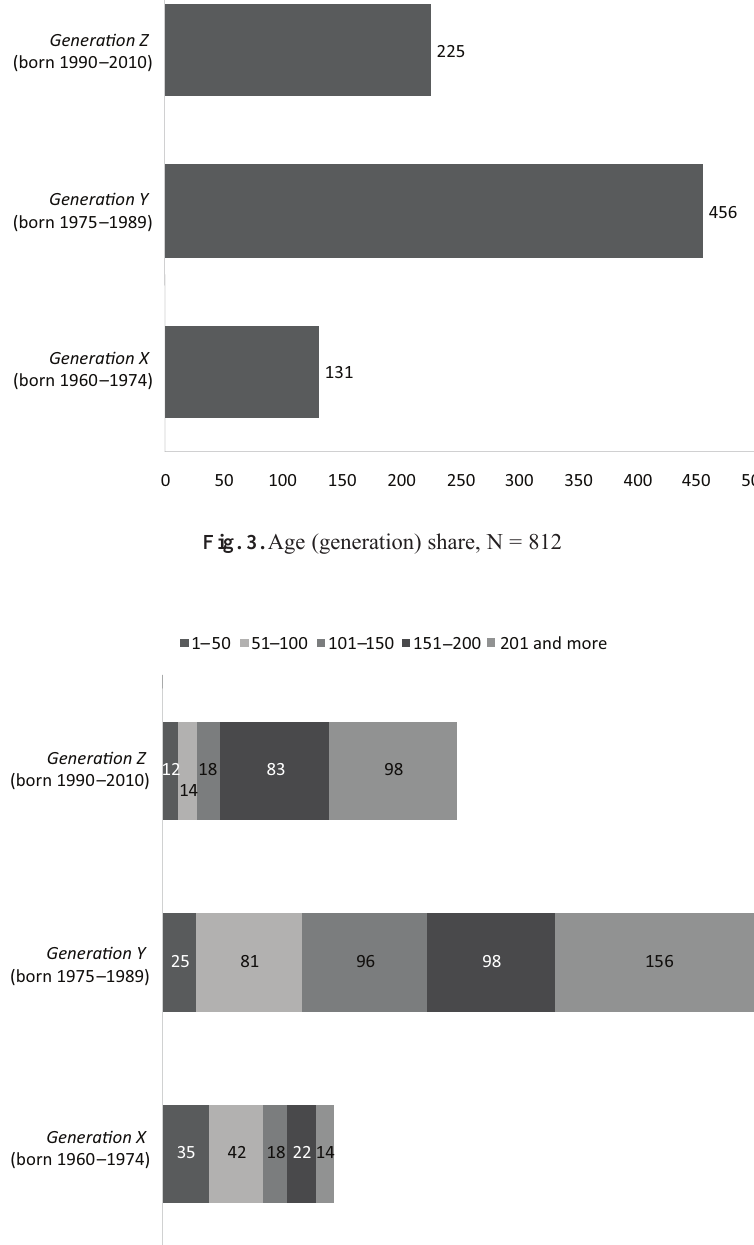
fig. 4. Number of social network connections (“friends”), N =